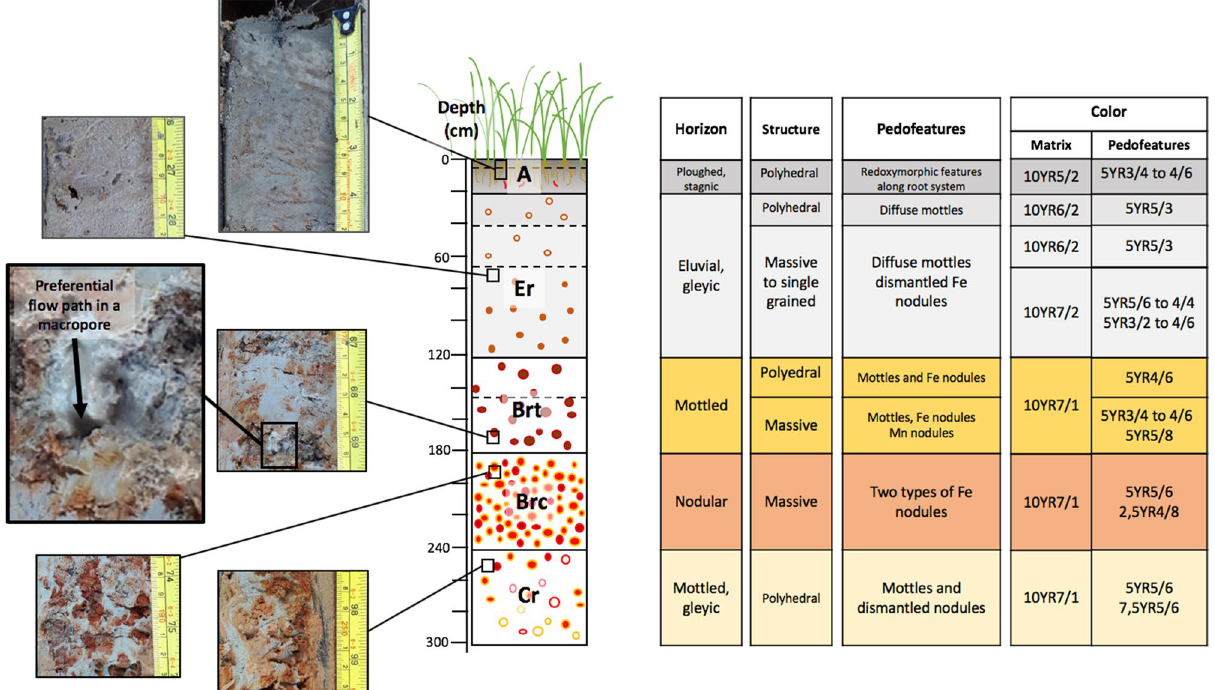
Figure 3. Morpho-pedological features of the studied soil profile: center, schematic of the soil log showing the vertical succession and thickness of the main horizons (i.e. A, Er, Brt, Brc and Cr); left, pictures showing colored features mainly related to iron redistribution, and a preferential water flow path in a macropore; right, synthesis table of the soil horizons structure, pedofeatures and colors (Munsell color chart 37